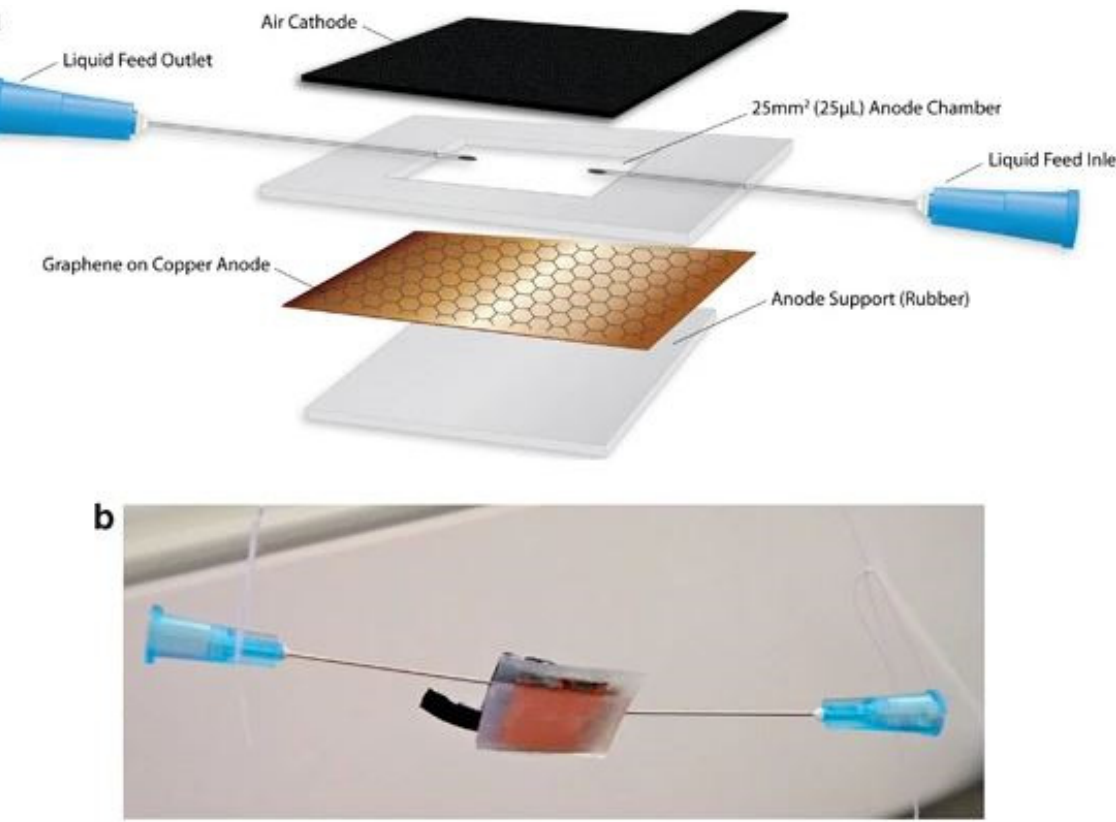
Figure 2. Micro-sized MFC ( a ) schematic and ( b ) digital photograph. Reproduced with permission from Ref. [52].